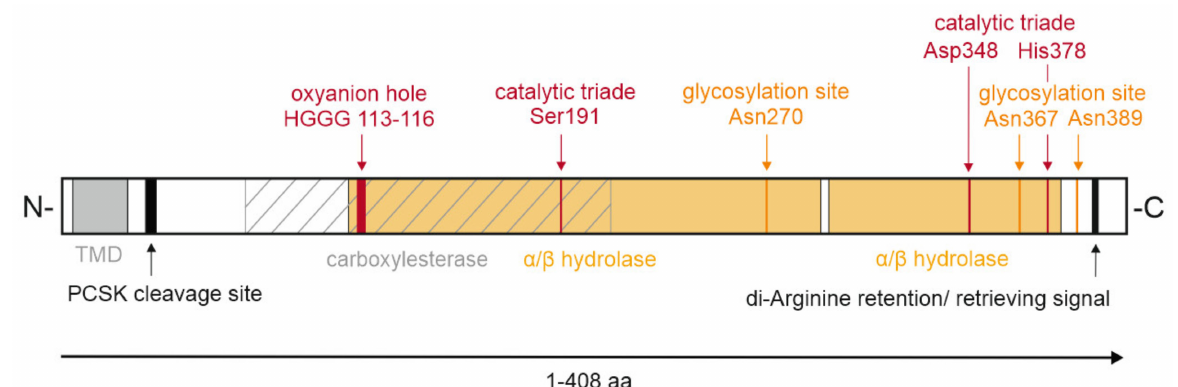
Figure 3. Domain organization of murine KIAA1363. Schematic representation of murine KIAA1363, with domain boundaries indicated. Single amino acids (aa) and sequences of specific functions are de- picted. The α / β -hydrolase fold is colored orange. The area of the carboxylesterase domain is hatched. PCSK, pro-protein convertases subtilisin/kexin type serine protease; TMD, transmembrane